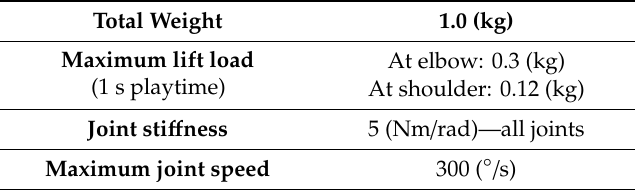
Figure 2. Compliant dual arm used in the experiments. Table 1. Main features of the lightweight and compliant dual